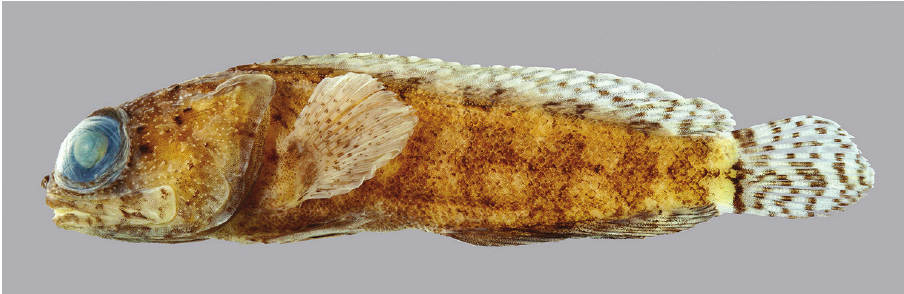
Figure 3. Opistognathus thionyi , CIUFES 2347, preserved holotype, 45.4 mm SL, male, Trindade Island, Brazil. Photograph by Zackary S.